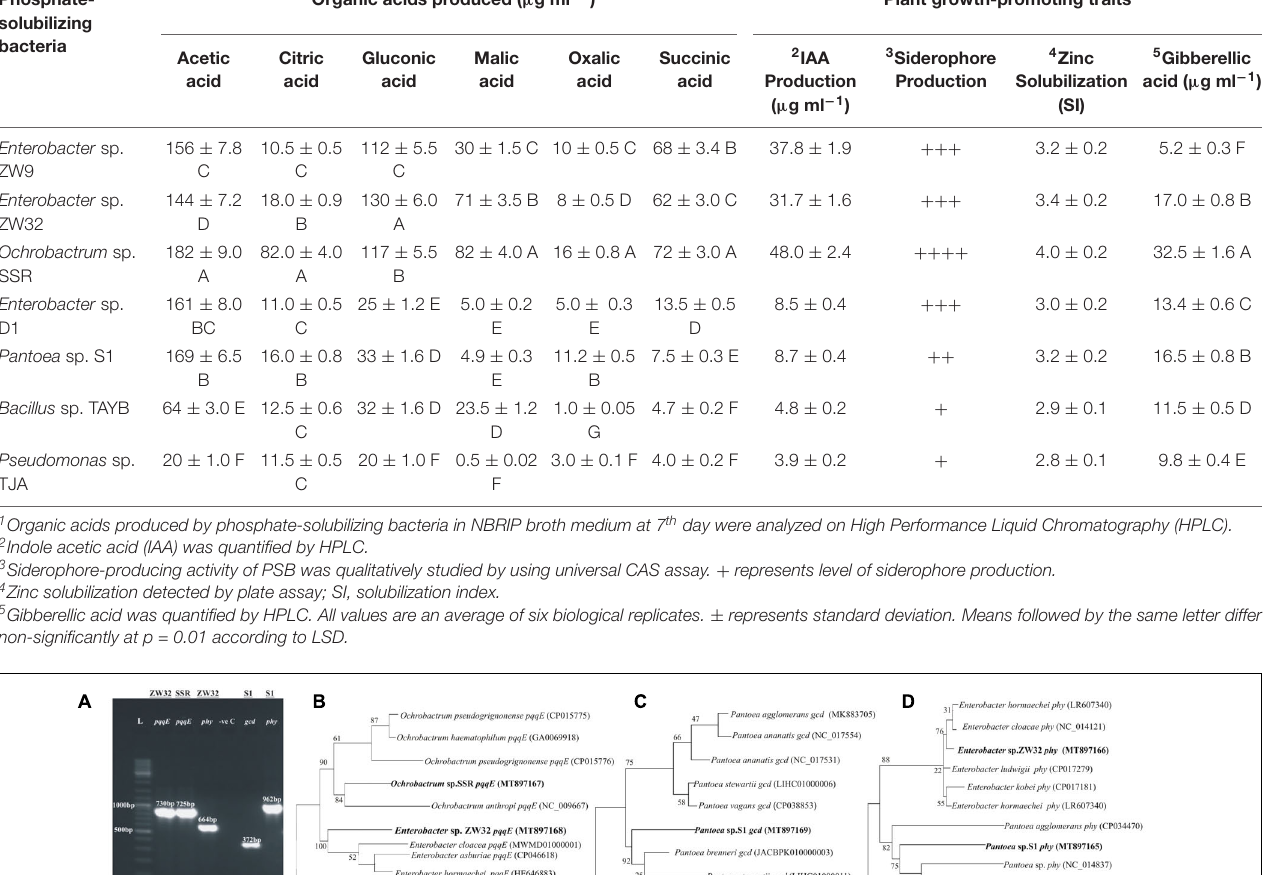
TABLE 1 | Plant growth-promoting traits and organic acids produced by phosphate-solubilizing bacteria. Phosphate- solubilizing